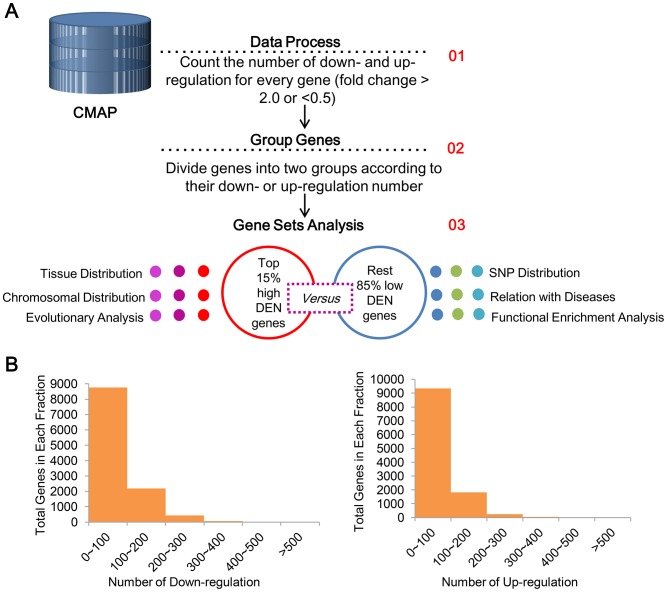
The overall view of the analysis.(A) The pipeline for the calculation of DEN of every gene from the CMAP dataset and the following computational analysis. (B) The distribution of down-regulation number (left) and up-regulation number (right) among the analyzed genes.